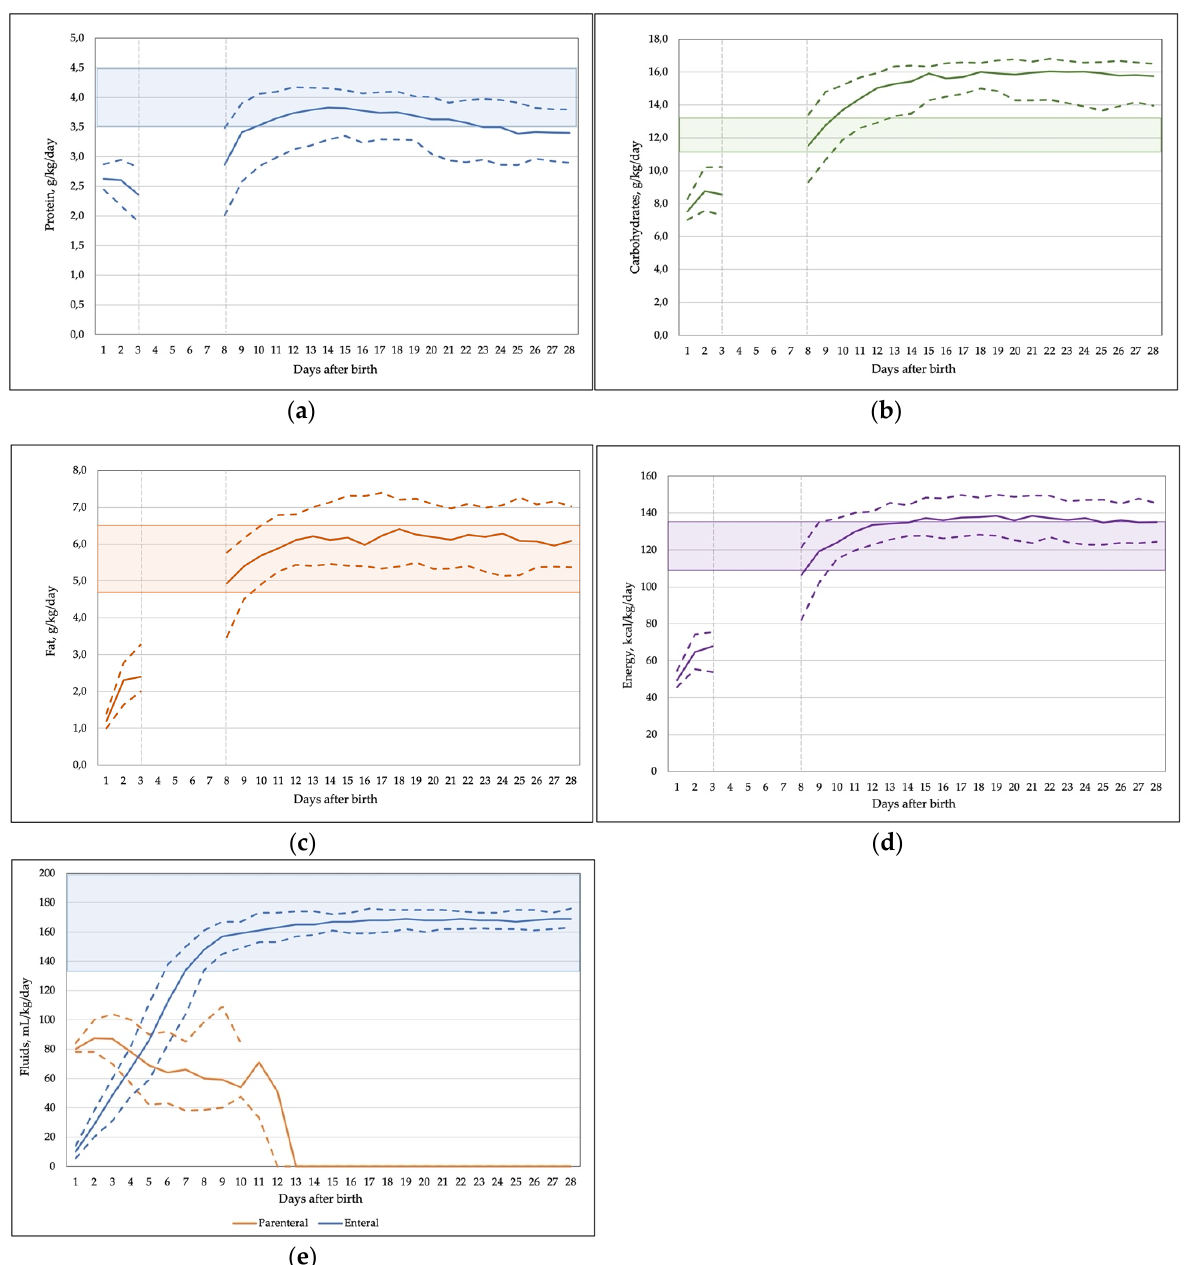
Figure 3. Macronutrient, energy, and fluid intake during the first 28 days. ( a ) Total daily protein intake, g/kg/day; ( b ) total daily carbohydrates intake, g/kg/day; ( c ) total daily fat intake, g/kg/day; ( d ) total daily energy intake, kcal/kg/day; ( e ) daily parenteral and enteral fluid intake, mL/kg/day. Data are median (solid line) and interquartile range (dashed lines). Shaded areas represent the range of recommended enteral nutrient intakes.